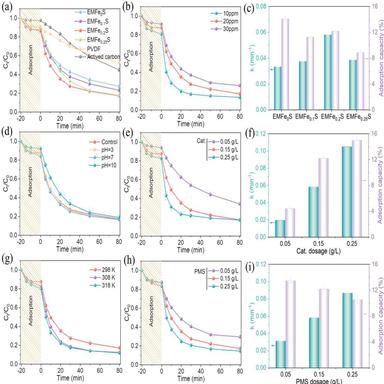
Effect of (a) cat. types; (b) TTCH concentration; (d) initial pH; (e) EMFe0.2S dosage; (g) temperature and (h) PMS dosage on TTCH degradation. (c) reaction rate, adsorption capacity and catalyst type; (f) reaction rate, adsorption capacity and catalyst dosage; (i) reaction rate, adsorption capacity and PMS dosage. Unless specifically explained, Reaction conditions: = 0.15 g L− 1 , = 0.15 g L− 1 , = 20 ppm, = 25 ◦C.